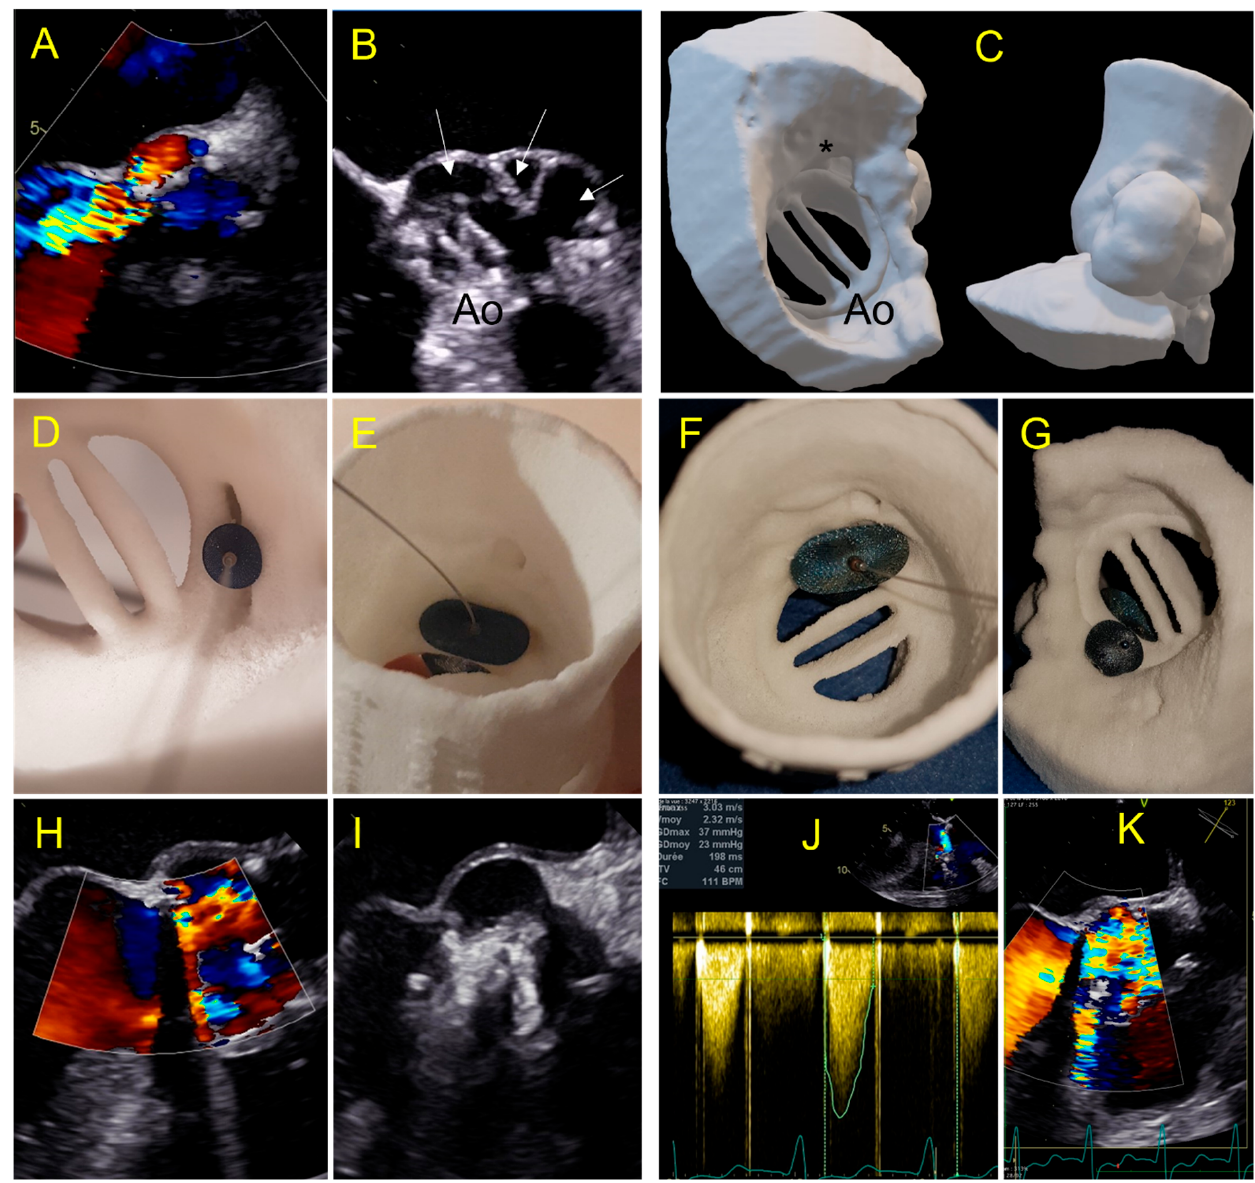
Figure 7. Case 4: complex aortic PVL secondary to paravalvular abscess. ( A ) Aortic PVL in color doppler TEE view; ( B ) multilobed abscess (white arrows) with large PVL.; ( C ) 3D printed model reproducing the multilobed abscesses and the paravalvular leakage with a complex tract with a ventricular outlet (*); ( D , E ) testing of an AVP 2–10 mm device and AVP 3-10 × 5 mm with a residual PVL ( E ); ( F , G ) testing of a 14 mm Amplatzer Valvular Plug 3 device which occludes the leak but has an interference with the leaflet ( G ); ( H , I ) procedural implantation of AVP 3 14 × 5 mm with no residual leakage and normal flow through the aortic prosthesis; ( J , K ) day one: Increased trans prosthetic gradient with turbulent aliasing flow ( K ) due to a leaflet blockage requiring rapid surgical management.